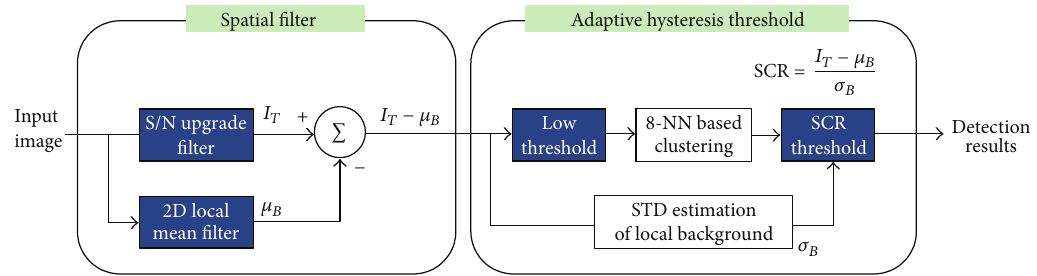
Figure 3: Spatial filter and adaptive hysteresis threshold-based small infrared target detection system.